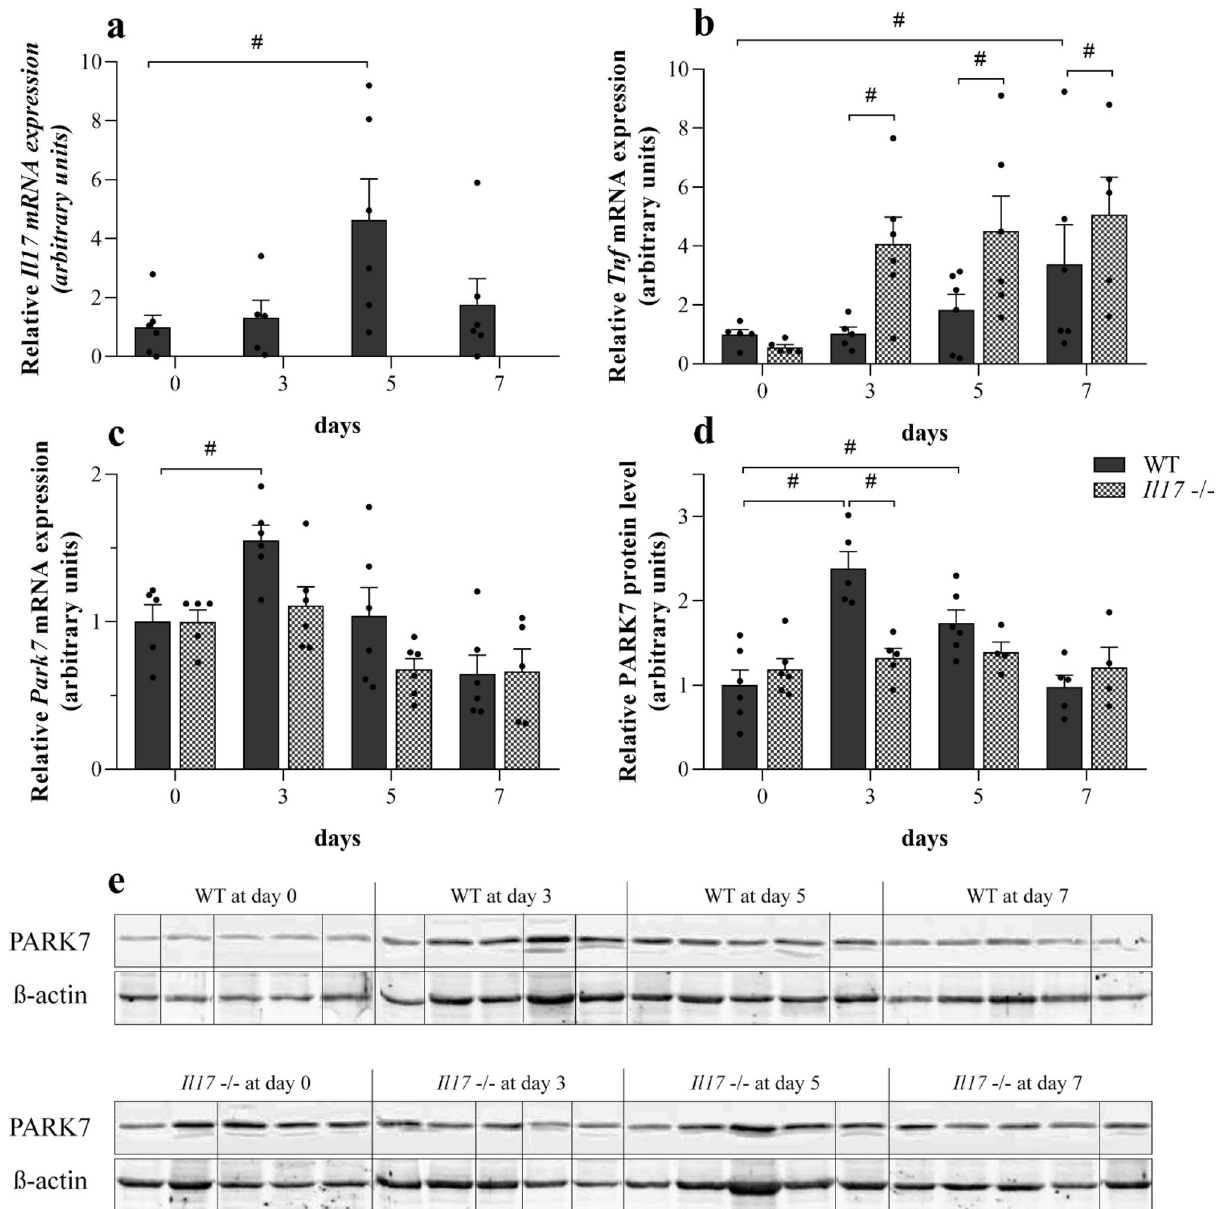
Figure 3. Effect of DSS on colonic Il17 , Tnfα and PARK7 synthesis of WT and Il17 −/− mice. Colonic mRNA expression of Il17 ( a ), Tnfa ( b ) and Park7 ( c ) and the protein level of PARK7 ( d , e ) were determined by real- time PCR ( a – c ) and Western blot ( d , e ) (n = 5–6). Relative expression levels are presented in comparison with Gapdh mRNA ( a – c ) or ß-actin protein ( d , e ) as internal control and normalized to WT at day 0 group. Results are illustrated as mean + SEM, dots represent individual values. Analysis of significance was performed by two-way ANOVA. # p < 0.05 comparing the connected groups. Full-length blots are included in “Supplementary